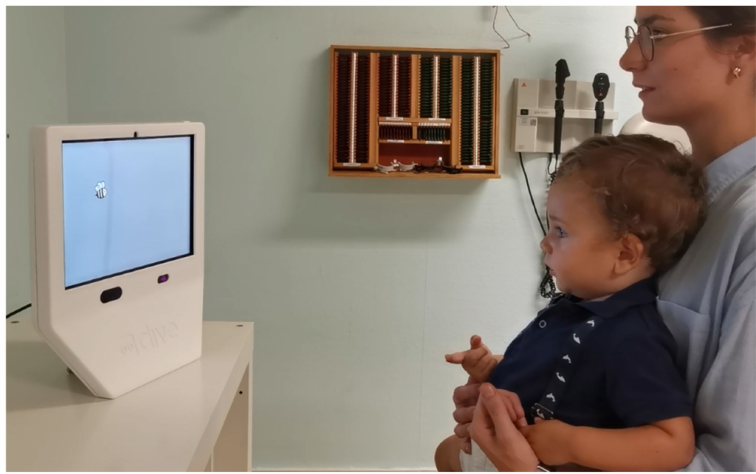
Figure 1. Representation of the device.